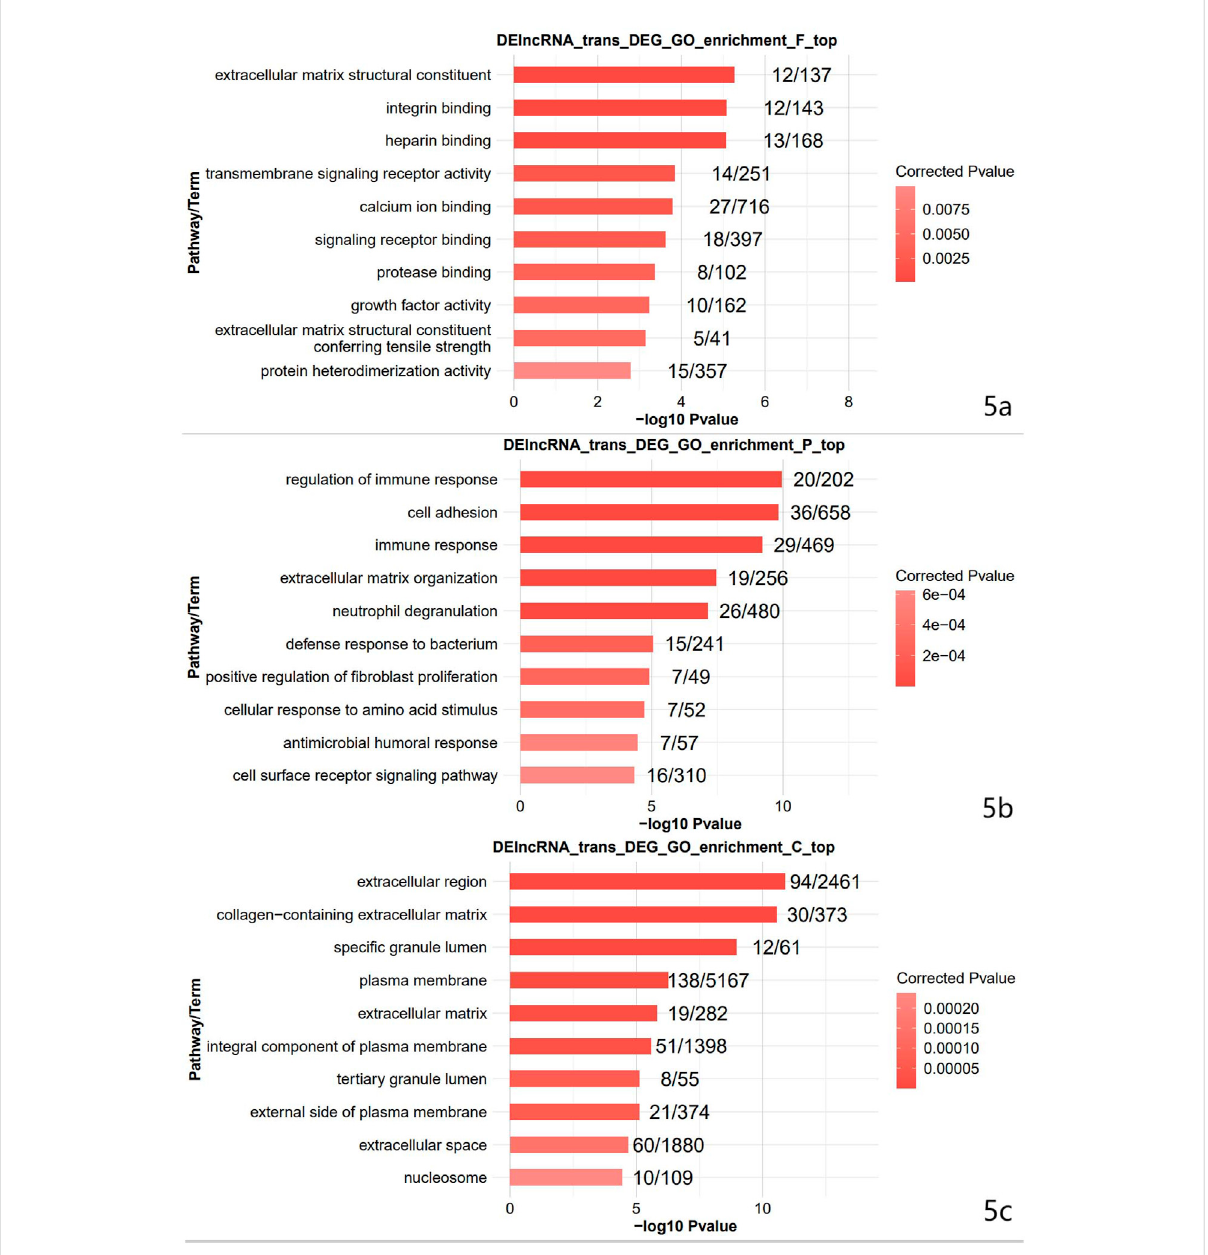
FIGURE 5 TheresultofGOenrichmentanalysis.GOisdividedintoMolecularFunction(Figure5A),BiologicalProcess(Figure5B),andCellularComponent (Figure